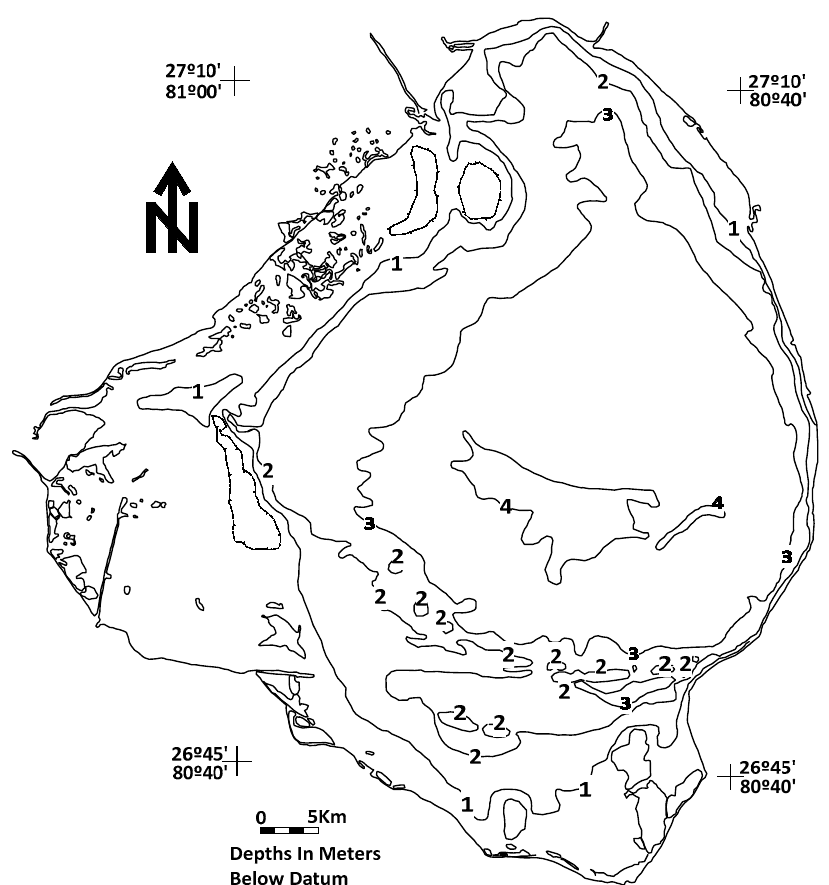
Figure 2. Bathymetry map of Lake Okeechobee relative to a datum of 3.81 m above mean sea level [7].